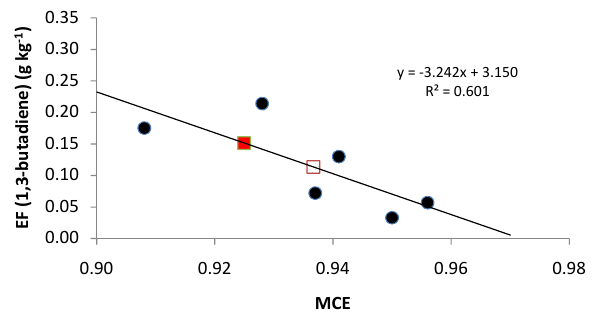
Fig. 2. The solid black circles show all 6 EF measurements on crop residue fires for 1,3-butadiene, and the open red square shows the average of those measurements (0.114gkg − 1 ) . The filled red square is the EF for 1,3-butadiene (0.151gkg − 1 ) computed from the fit at the average MCE for all 14 crop residue fires sampled in Mexico. The value from the fit is 32% larger, more consistent with the average MCE, and likely better reflects the average EF (see